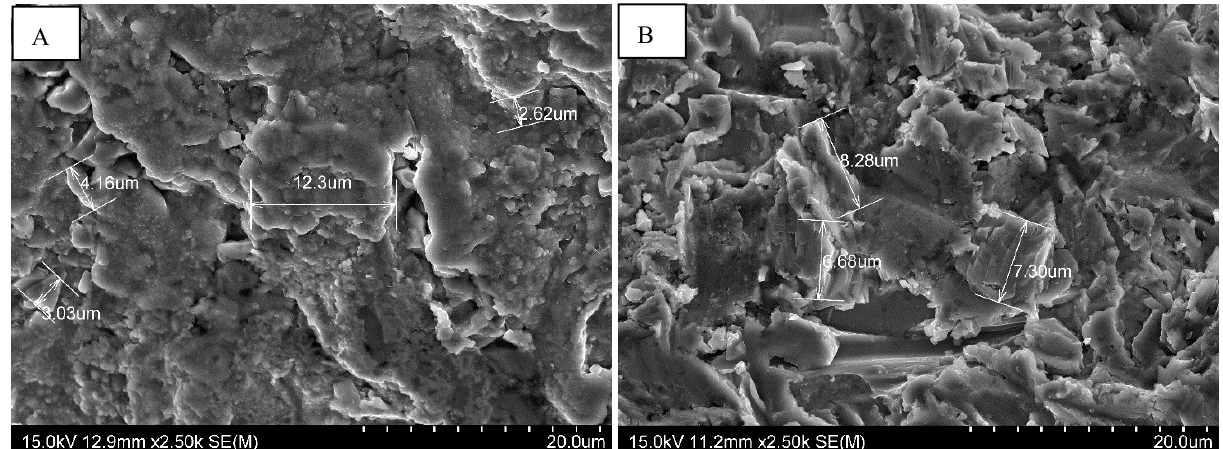
Figure 4. SEM images of Idcam ® implants from IDI System ( A ) and Natéa ® from Euroteknika ( B ) showing a Nanomeric appearance of surfaces: Magnification ×2500.